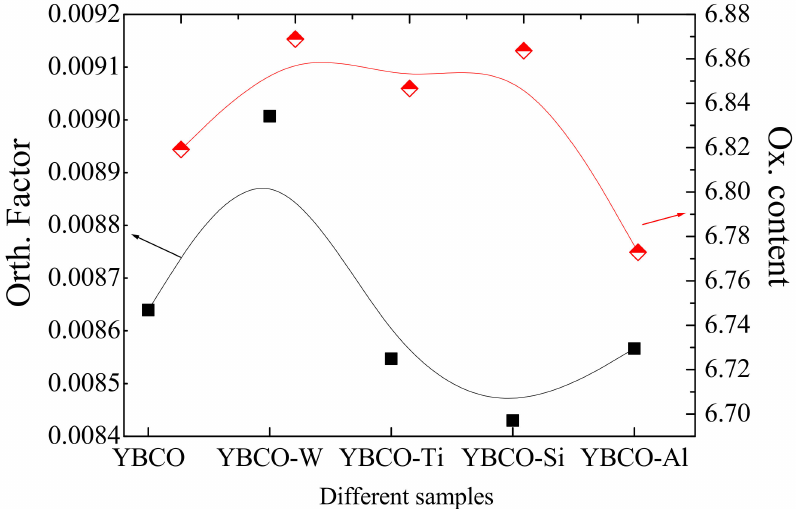
Figure 3. Variations of the Orth. factor (left axis) and O x content (right axis) with different